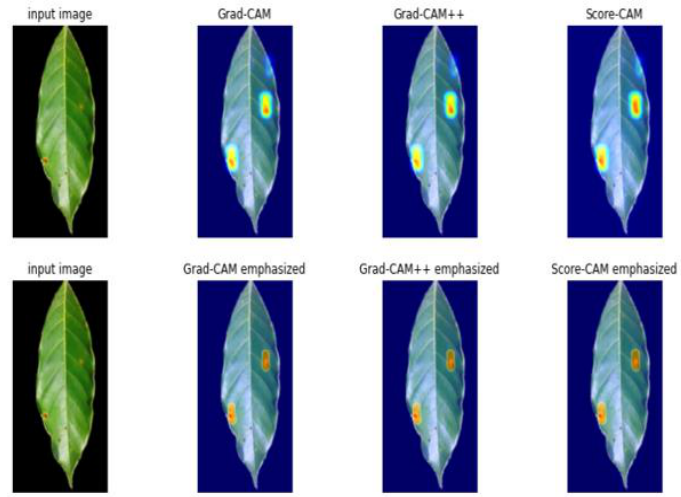
Figure 14. Visualization Result of Grad-CAM, Grad-CAM++, and Score-CAM. Grad-CAM and Score-CAM both show the ability to locate defected regions, but the saliency maps of Score-CAM are more focused than those of Grad-CAM++. For this